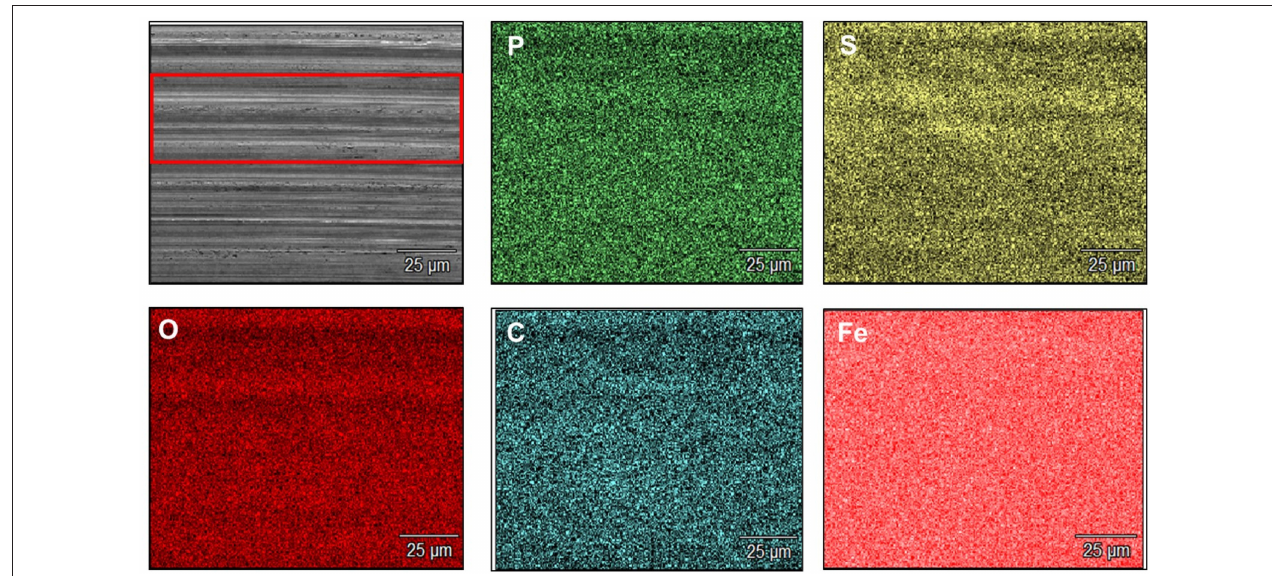
FIGURE 10 | Energy dispersive spectroscopy mapping for wear scar from four ball wear tests of grease blend with MWCNT_P IL1 at a magnification of